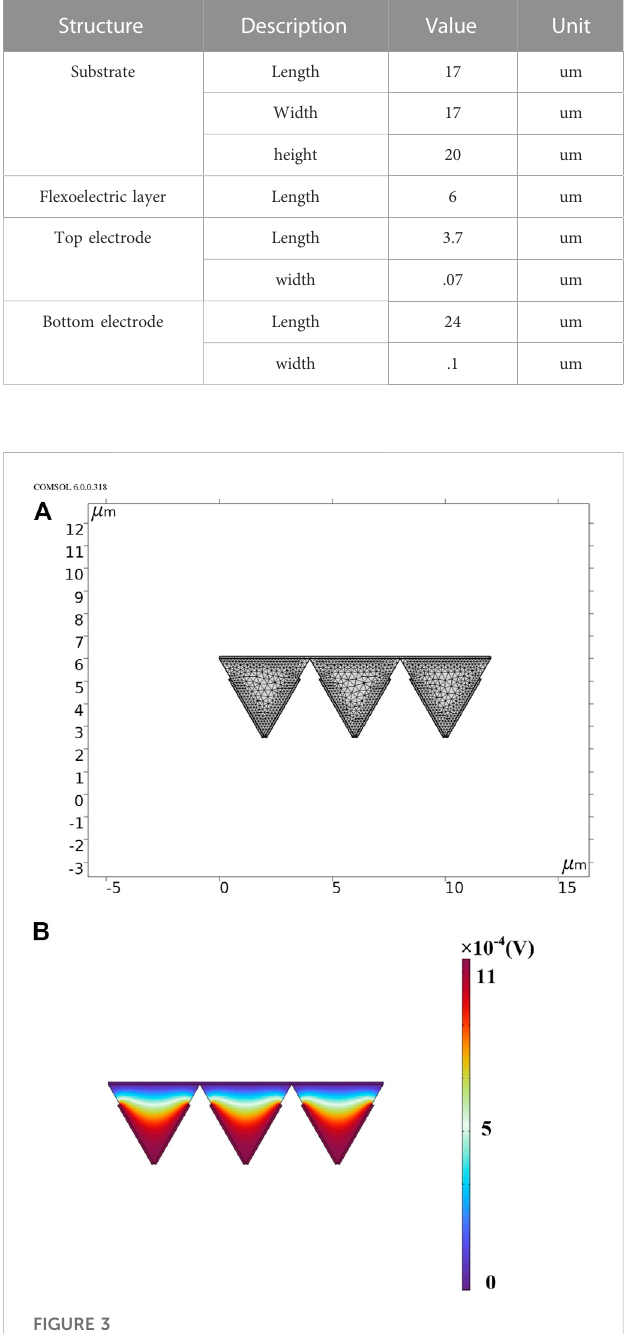
FIGURE 3 (A) This sthemeshdivisiondiagramoftheconicalstructure (B) This s the potential distribution of the conical structure